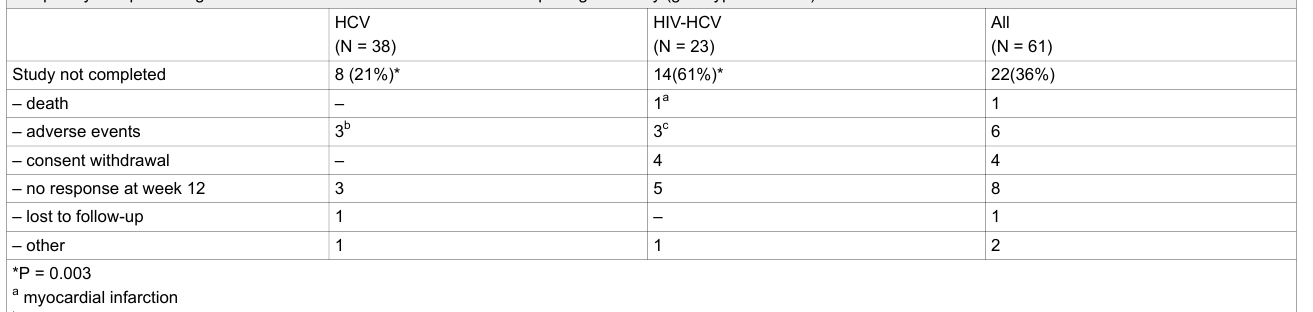
Table 4 Frequency and percentage of adverse events and reasons for not completing the study (genotypes 1 and 4).